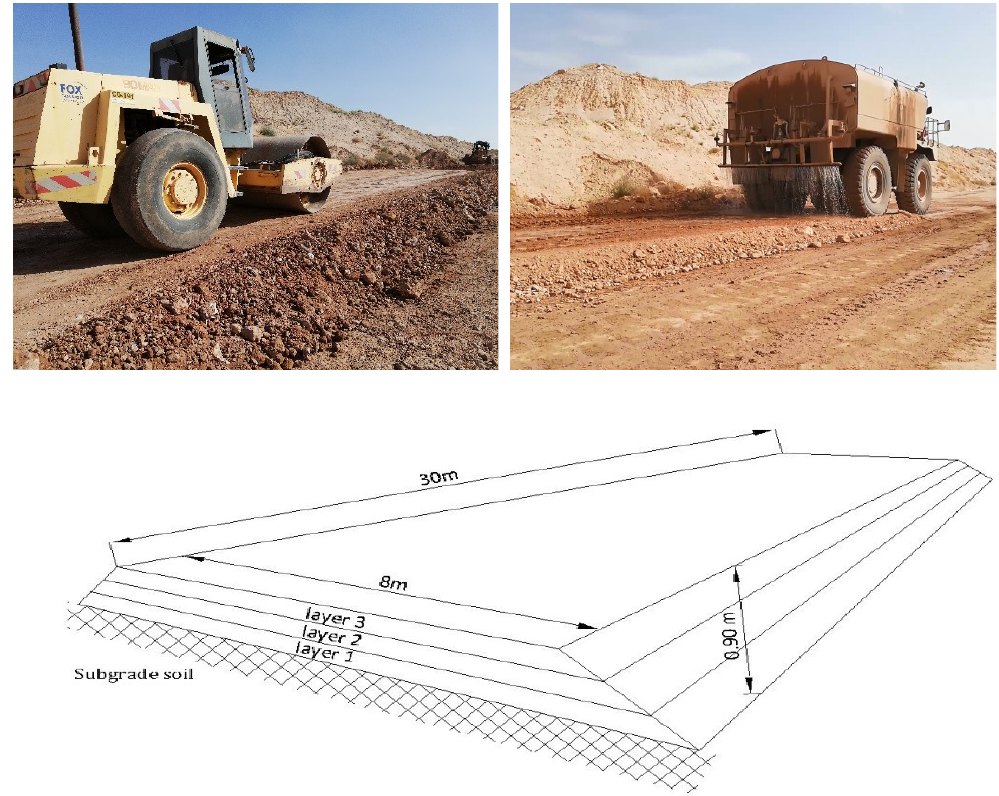
Figure 4. Photos and scheme illustrating the field trial embankment construction.